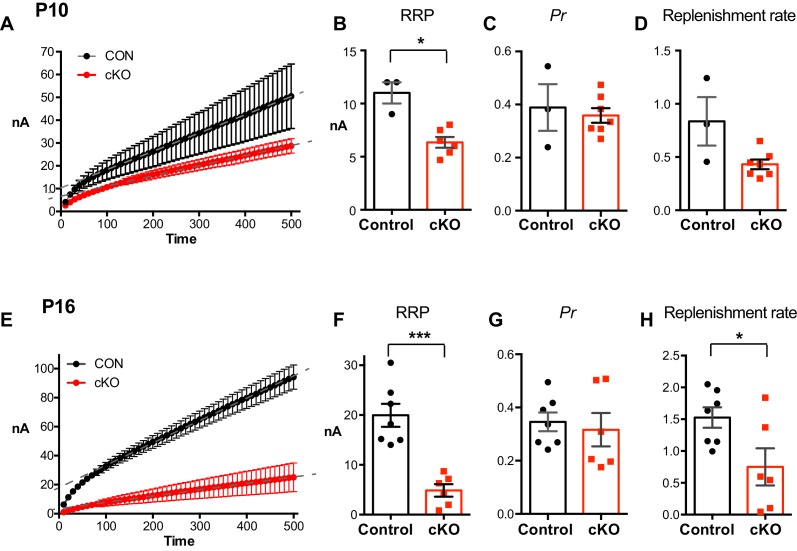
RRP and replenishment rate of calyces in cKO.(A) Plot of the cumulative eEPSC against stimulus number in control and cKO mice at P10. A line fit to the steady-state points is back-extrapolated to the y-axis to estimate the RRP. (B–D) Summary of RRP, Pr, and replenishment rate from immature calyces. *p<0.05 (Mann-Whitney test). (E) Plot of the cumulative eEPSC against stimulus number in control and cKO mice at P16. (F–H) Summary of RRP, Pr, and replenishment rate from mature calyces at P16. Data are shown as the mean ± s.e.m. *p<0.05; ***p<0.001 (unpaired t-test).